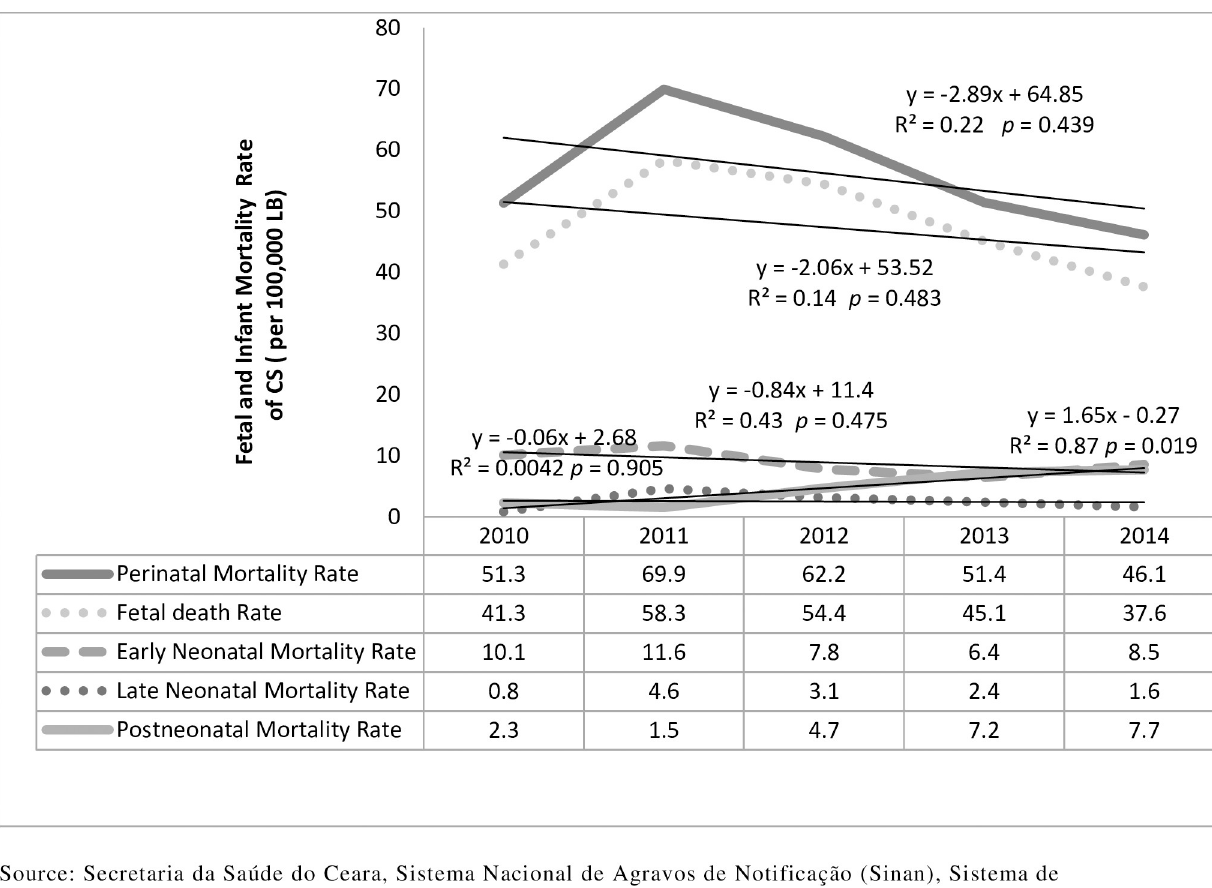
Fig 4. The fetal, perinatal, neonatal (early and late) and postneonatal mortality rate of congenital syphilis. Ceara´, Brazil, 2010–2014.